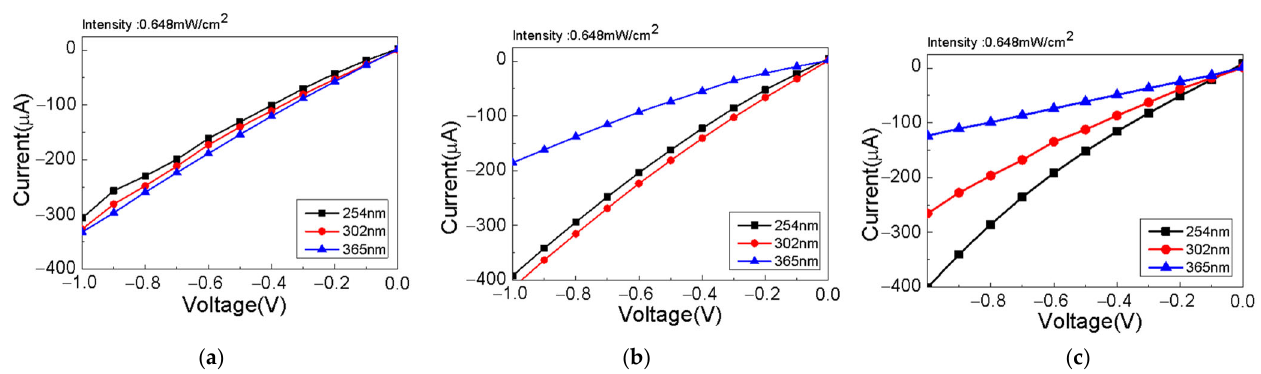
Figure 6. Current–voltage curves of FAPbX 3 ‐ MAPbX 3 (X = I, Br, and Cl) photodetectors at different wavelengths of light: ( a ) X = I, ( b ) X = Br, and ( c ) X = Cl.